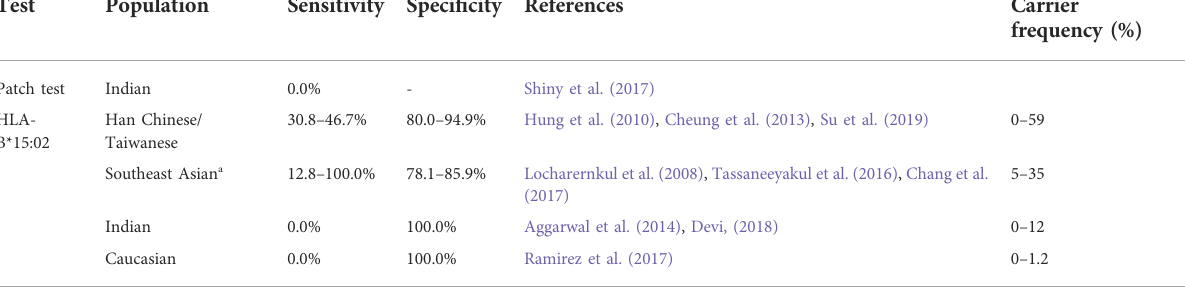
TABLE 5 Sensitivity and speci fi city of patch tests and HLA tests for phenytoin-induced SJS/TEN. Test